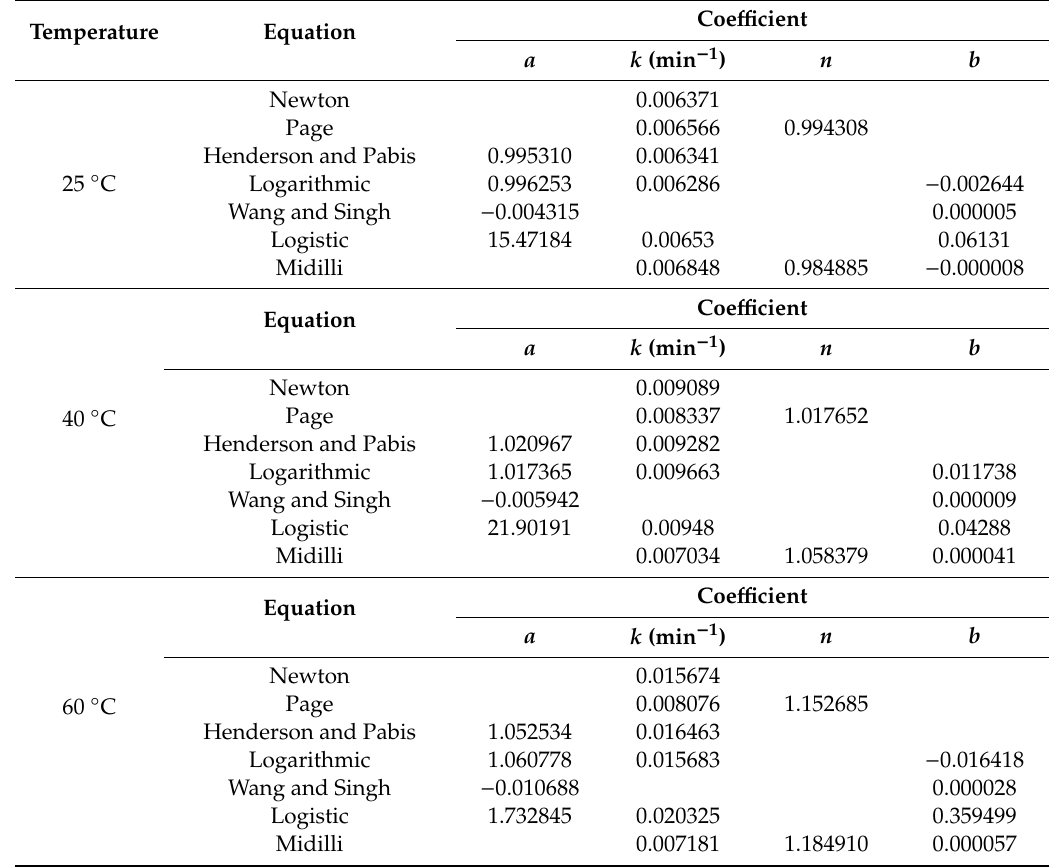
Table 5. Values corresponding to di ff erent models describing the air drying of wild strawberry